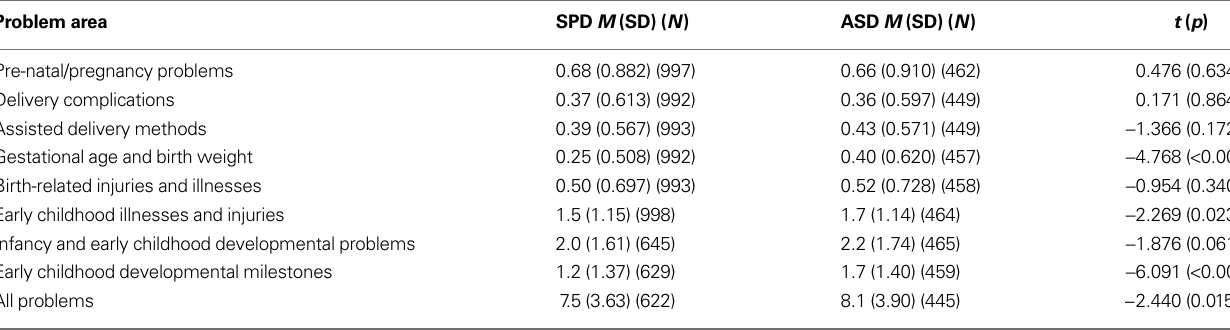
Table 9 | Means, standard deviations, valid N, and T -tests of multiple problems by category. Problem